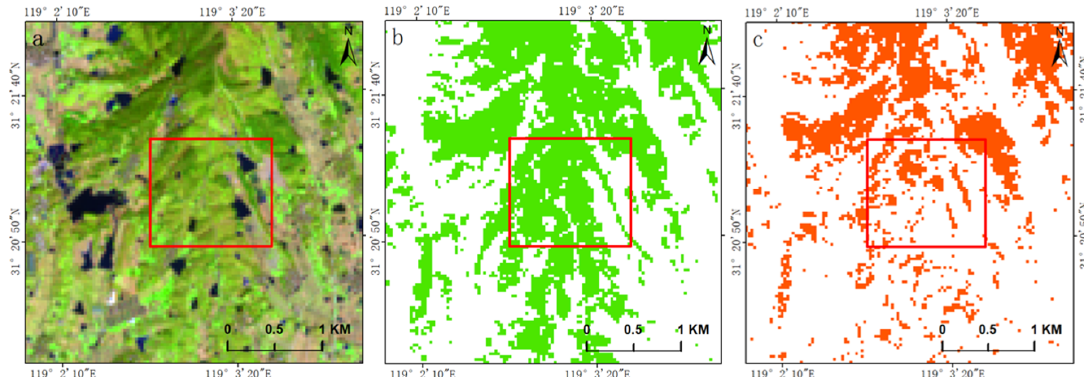
Figure 7. Comparison of maps with the 30-m Landsat 8 Thematic Mapper (TM) image on 9 February 2016. ( a ) Evergreen trees appear as green on composite Landsat 8 TM images combined as false color (6/5/4). ( b ) Subtropical evergreen trees in the study area based on the NDVI-CV model. ( c ) Map of the LSWI min model.